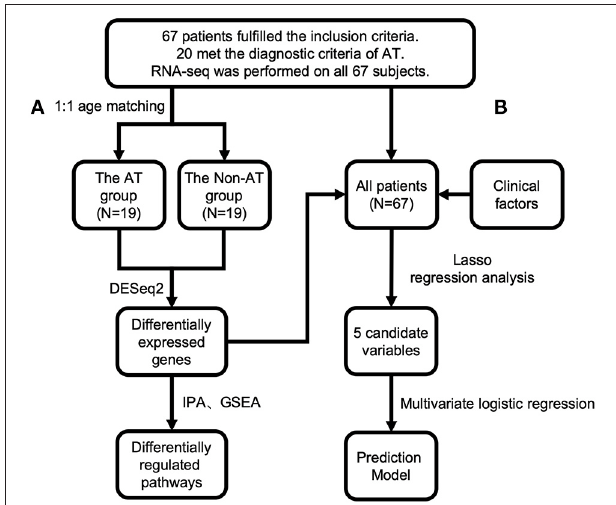
FIGURE 1 | Study design and procedures of prediction model building. Sixty-seven patients fulfilled the inclusion criteria, among whom 20 had atherosclerosis (AT) by our definition. RNA sequencing (RNA-seq) was performed on all 67 patients. (A) For the differential expression analysis, 1:1 age-matched systemic lupus erythematosus (SLE) AT group ( n = 19) and SLE Non-AT group ( n = 19) were used. Ingenuity Pathway Analysis (IPA) and gene set enrichment analysis (GSEA) were performed with differentially expressed (DE) genes. (B) All 67 samples were used to build the prediction model for atherosclerosis. DE genes from (A) and clinical atherosclerosis risk factors were used as candidate variables for LASSO selection. Five variables were selected. A multivariate logistic regression was further applied to the five variables. Variables were excluded sequentially by the highest p -value in the multivariate logistic regression until all remaining variables had significant p -values. Three final variables were selected to build the final prediction model with multivariate logistic